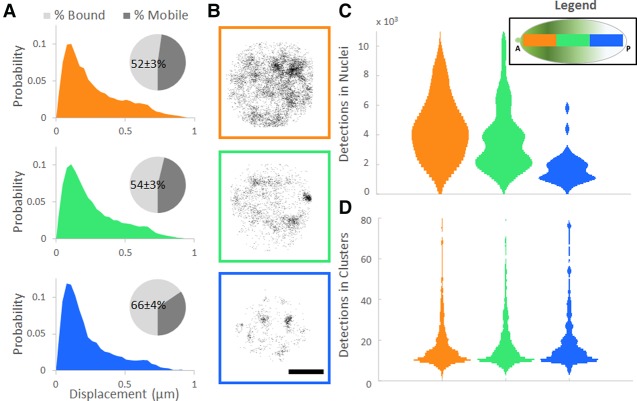
Local modulation of BCD concentration. (A) Normalized probability distributions of measured displacements in the anterior (30 nuclei), middle (67 nuclei), and posterior (66 nuclei) positions of the embryos; pie charts show the estimated mobile and bound fractions from fits to a two-population distribution, with the bound population percentage labeled with the standard error of the fit parameter. (B) Examples of the spatial distribution of all detections in nuclei along the A–P axis. Bar, 2.5 µm. (C) Distribution of the number of detections in all nuclei. (D) Distributions of the number of detections within all clusters.